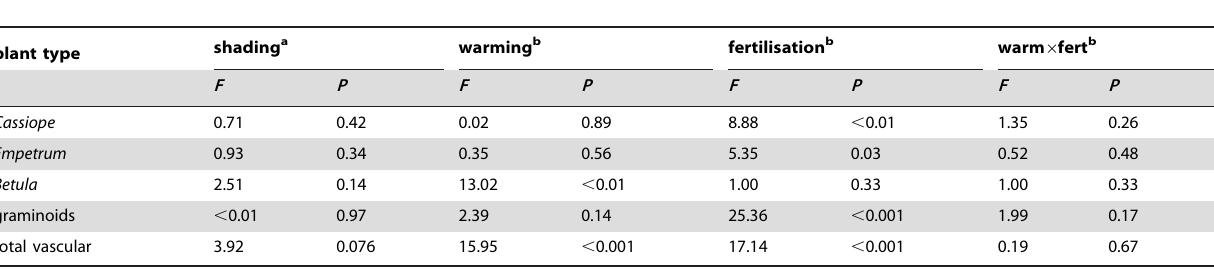
Table 2. Results of ANOVAs on the coverage of the dwarf-shrubs Cassiope tetragona and Empetrum hermaphroditum , the low shrub Betula nana , the graminoids and the total vascular species at a subarctic heath in Abisko (Northern Sweden) after 22 years of environmental